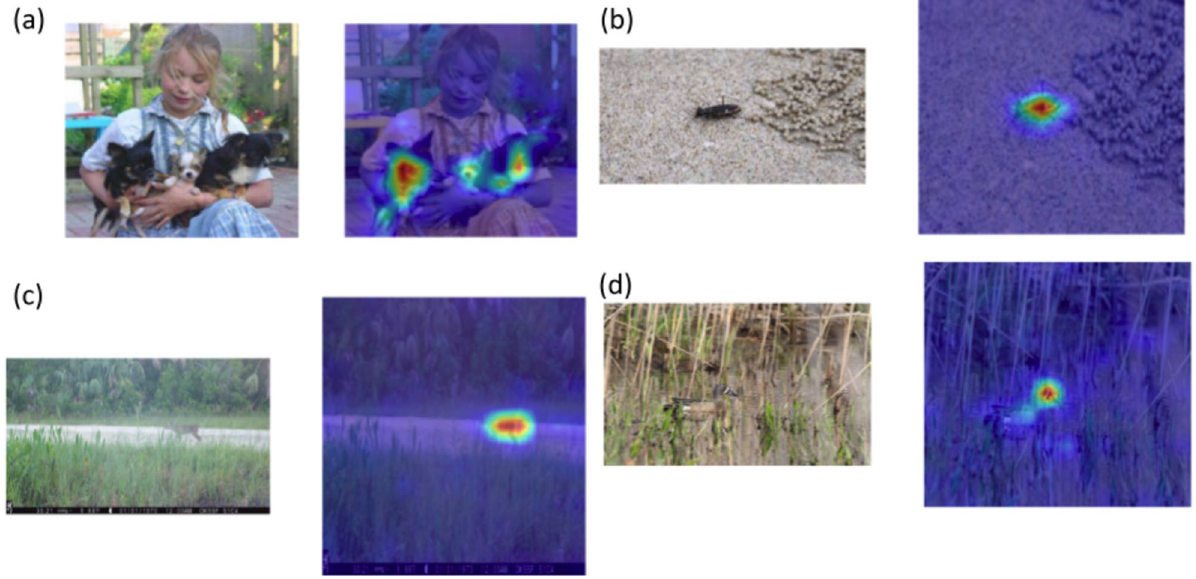
Figure 3. Examples of DeiTs identifying images from different datasets: ( a ) Stanford Dogs, ( b ) SriLankan tiger beetles, ( c ) Florida wild-trap, and ( d ) NA-Birds datasets are visualized. The original image is shown on the left in each panel, while the right reveals where our model is paying attention while classifying the species in the image.